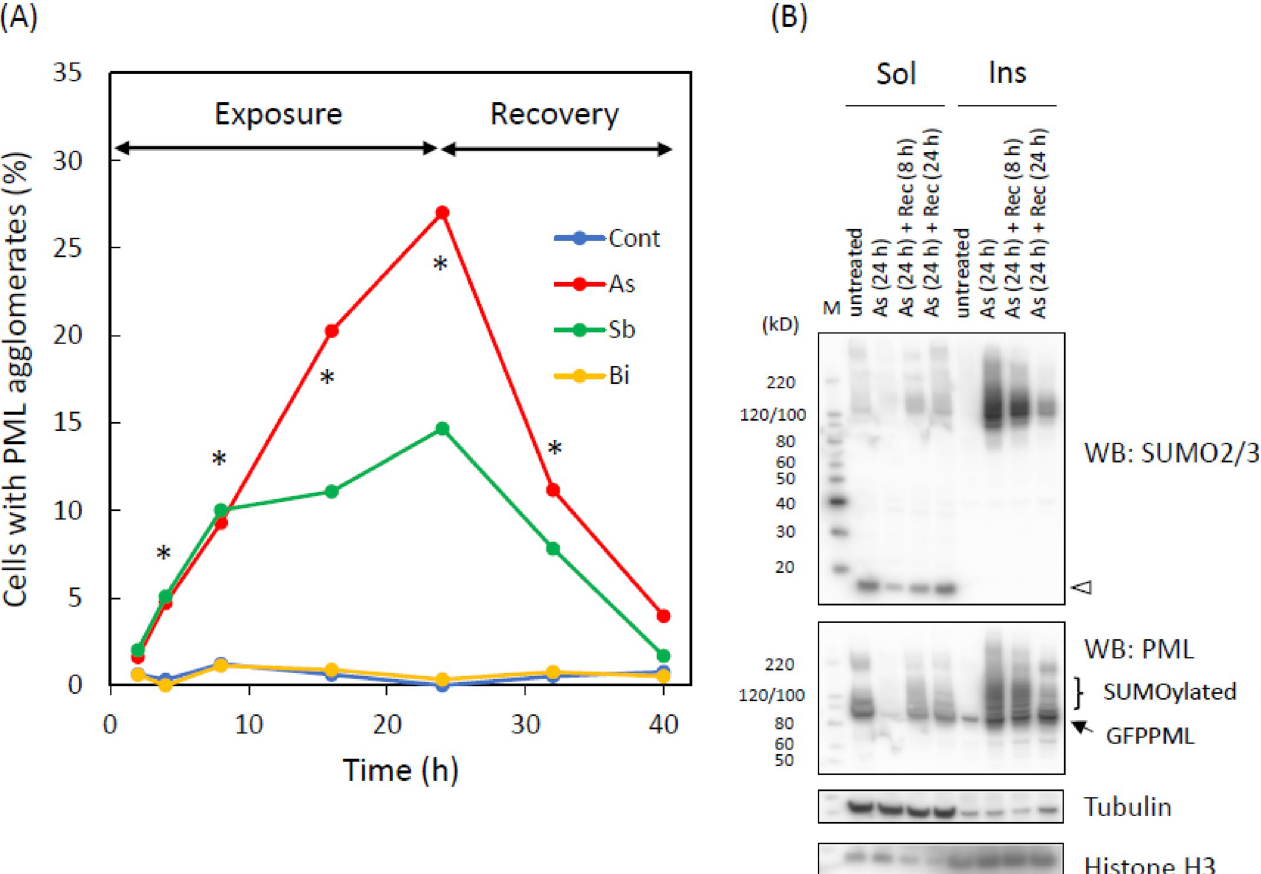
Fig 5. Changes in the percentage of cells with agglomerated PML–NBs (A), and recovery of PML in the RIPA–soluble fraction (Sol) from a 24 h–exposure to As 3+ in CHOGFPPML cells (B). (A) The cells were exposed to 3 μ M As 3+ , Sb 3+ , or Bi 3+ for 24 h, and further cultured in fresh medium for 16 h. The numbers of cells with the agglomerated PML–NBs were counted at 2, 4, 8, 16, 24, 32 (8 h in recovery), and 40 h (16 h in recovery). At least 300 cells of each group were examined for the presence of agglomerated PML–NBs. The agglomeration was defined as five or more than five PML–NBs in an aggregated form. � , Significantly different among the groups as examined by χ 2 test. (B) The cells were first exposed to 3 μ M As 3+ for 24 h. The cells were lysed with the RIPA buffer immediately or washed and further cultured in As 3+ –free culture medium for 8 or 24 h before lysis. Lane 1 and 5, untreated; Lane 2 and 6, 24–h exposure to As 3+ ; Lane 3 and 7, 24–h exposure to As 3+ and 8–h recovery in As 3+ –free culture medium; Lane 4 and 8, 24–h exposure to As 3+ and 24–h recovery in As 3+ – free culture medium. The unconjugated GFPPML and GFPPML conjugated with SUMO2/3 in the RIPA–insoluble fraction (Ins) decreased during the culture in As 3+ –free culture medium. An open arrowhead indicates SUMO2/3